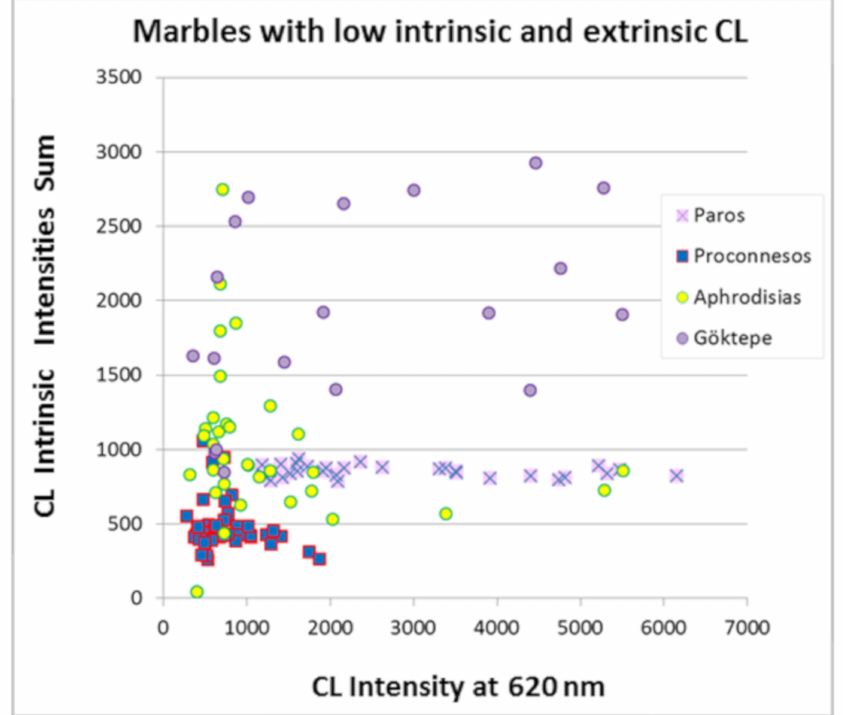
Figure 6. Quantitative CL diagram for classical marbles with low intensity in both